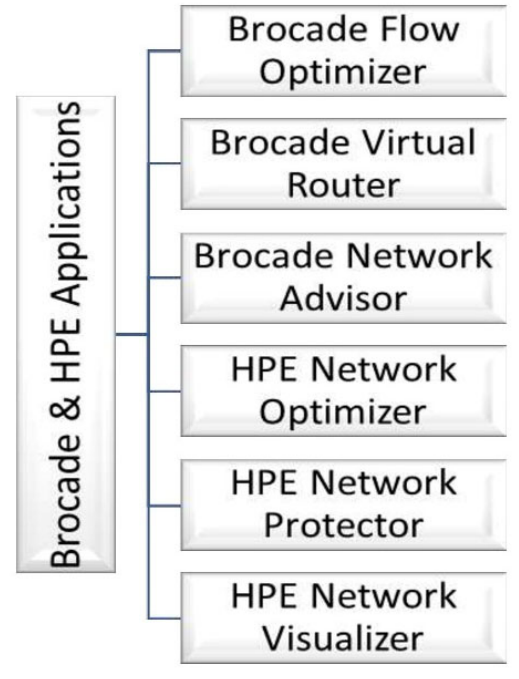
Figure 6. Brocade and HPE applications.